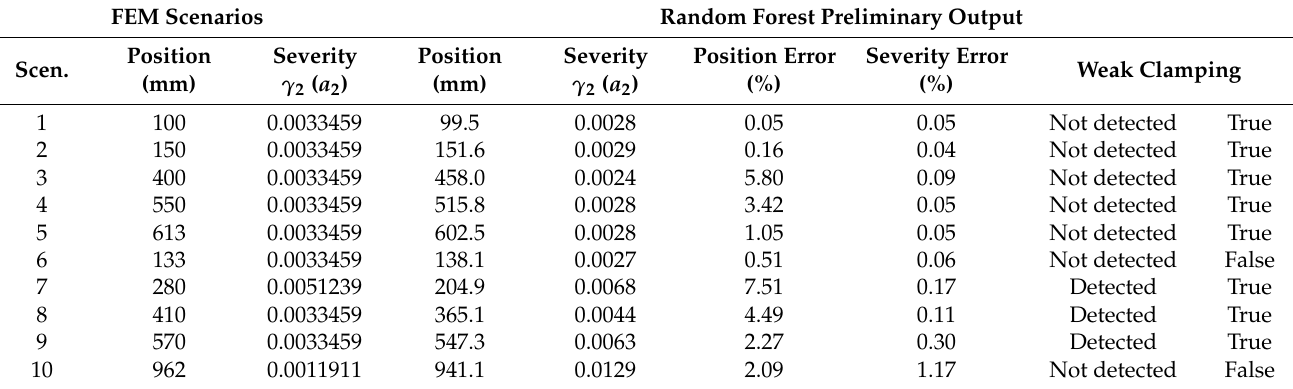
Table 5. Results obtained using Random forest rough model—first